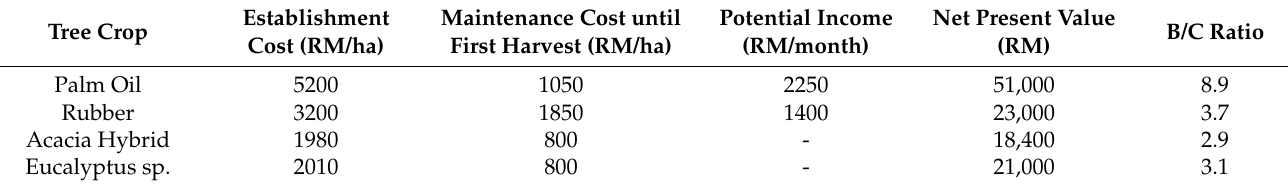
Table 8. Cost-benefit Analysis of Forest Plantations versus Rubber and Palm Oil on a 25 Year Rotation. Tree